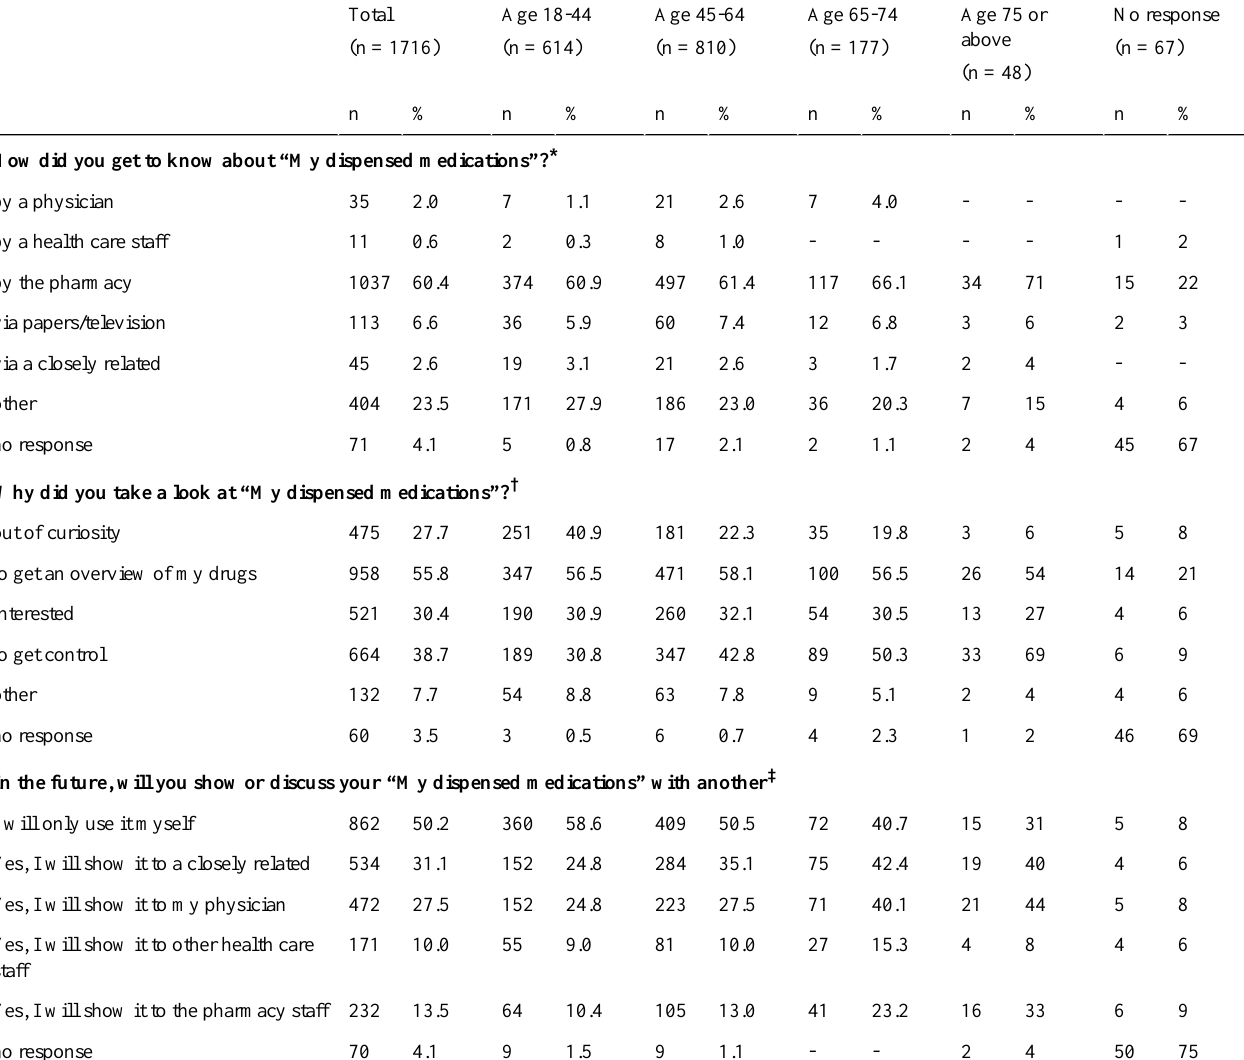
Table 2. Number (n) and percentage (%) of respondents for different response alternatives to 3 questions